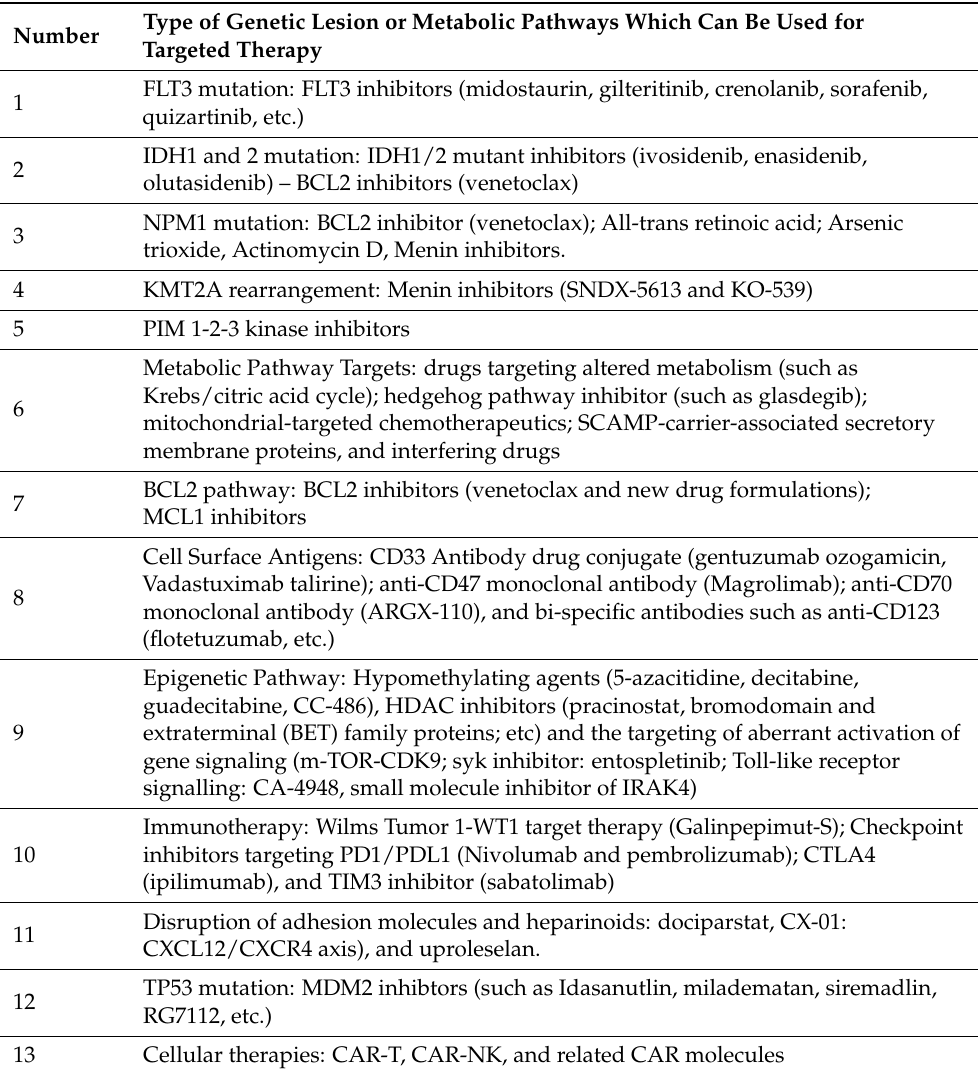
Table 1. Druggable genetic lesions and targeted therapy in